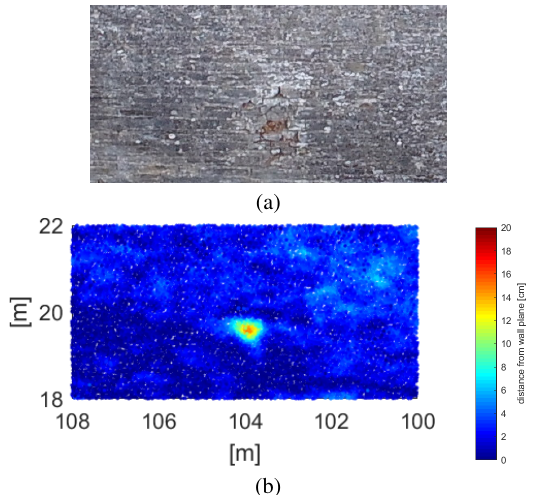
Figure 9. Close front view of a Fortress wall (a) and correspond- ing depth analysis with respect to the planar surface locally fitting the wall